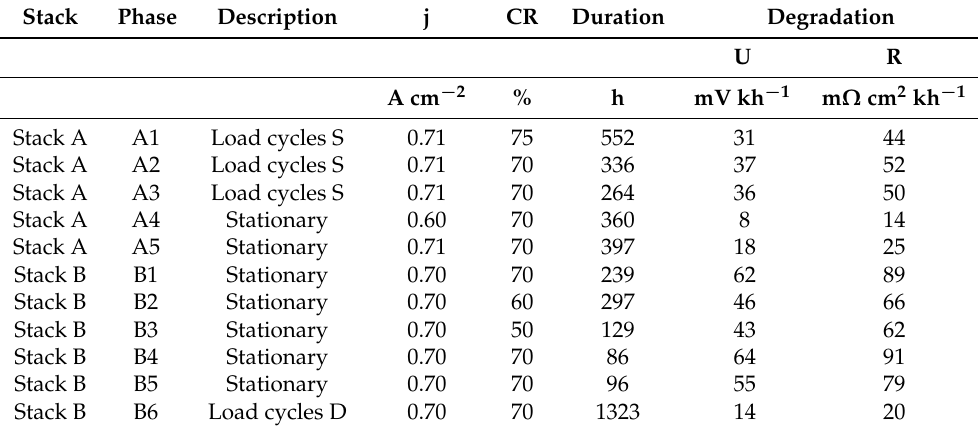
Table 2. Operational